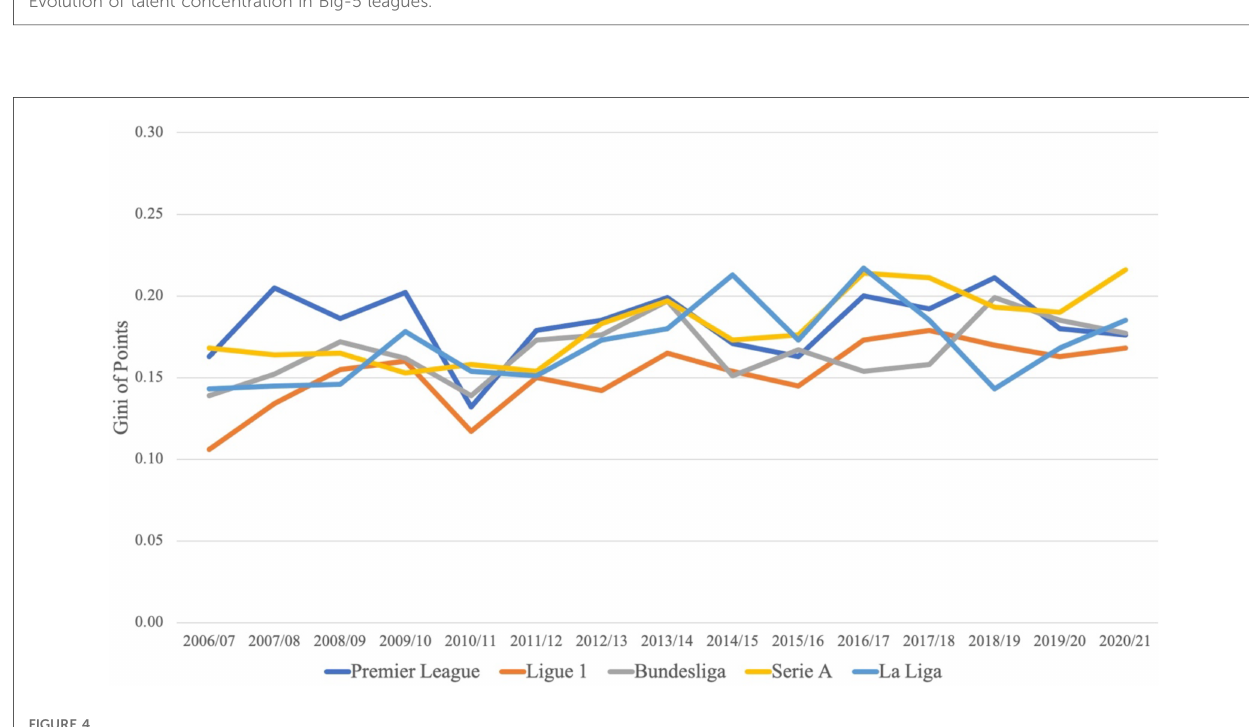
FIGURE 4 Evolution of points concentration in Big-5